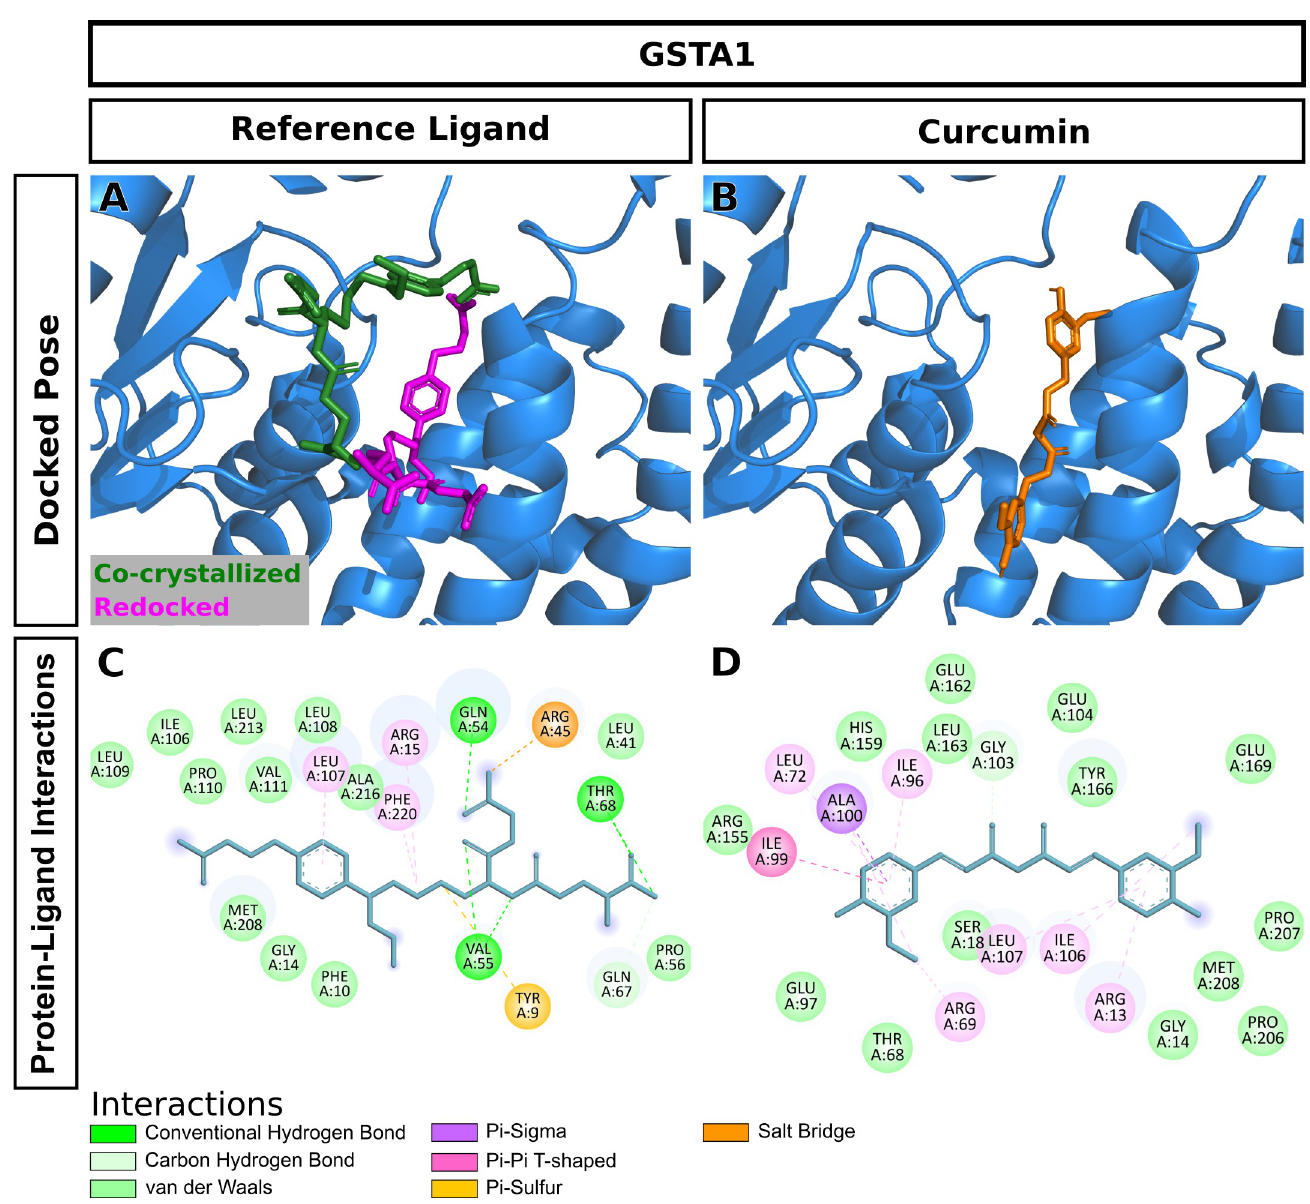
Fig 7. Molecular docking of curcumin to GSTA1. (A) Redocking of the bound ligand. (B) Docking pose of curcumin. (C) Interactions of the bound ligand with the protein. (D) Predicted interactions of curcumin with the protein. reference ligand C1-27, curcumin also had a stronger binding affinity for GSTO1 (Table 2). Vina performed exceptionally well to reproduce the docking pose of the co-crystallized inhibi- tor C1-27 (Fig 8A). Interestingly, curcumin also occupied the binding pocket of GSTO1 (Fig 8B) with an extended structure. More importantly, many interacting residues, including CYS32, PRO33, PHE34, LEU56, VAL72, PRO124, ILE131, TRP180, and TYR229, were com- mon for curcumin and C1-27 (Fig 8C and 8D). It can be assumed that curcumin will be a potent inhibitor for GSTO1. For KEAP1, Vina docking showed a slightly weaker interaction of curcumin than the bound ligand (Table 2). Both curcumin and the reference ligand 08A were